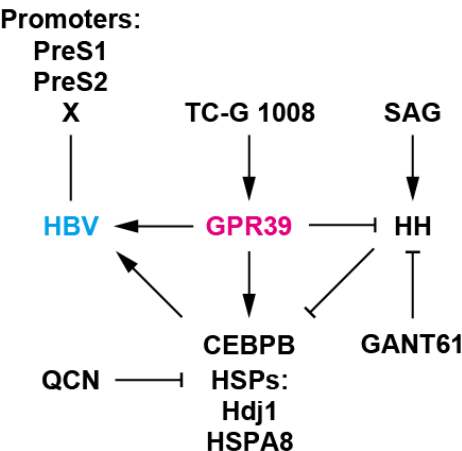
Figure 6. A working model of GPR39-centered network. GPR39 supported HBV replication, enhancing viral promoter activities as well as RNA levels and expression of HSPs such as Hdj1 and HSPA8 and CEBPB, well-known host cellular factors for HBV. TC-G 1008 is an agonist of GPR39 [34] and QCN is an inhibitor of HSP transcription and HBV [41]. Meanwhile, HH signaling, a GPR39 target, suppressed HBV replication as well as expression of HSPs and CEBPB. SAG is an HH signaling agonist [45] and GANT61 is a GLI inhibitor [43]. GPR39 thus orchestrates intracellular circuits, providing a proviral environment, and alteration in expression is conducive to pathogenic effects [52] as observed with HCC-related GPCRs [17].